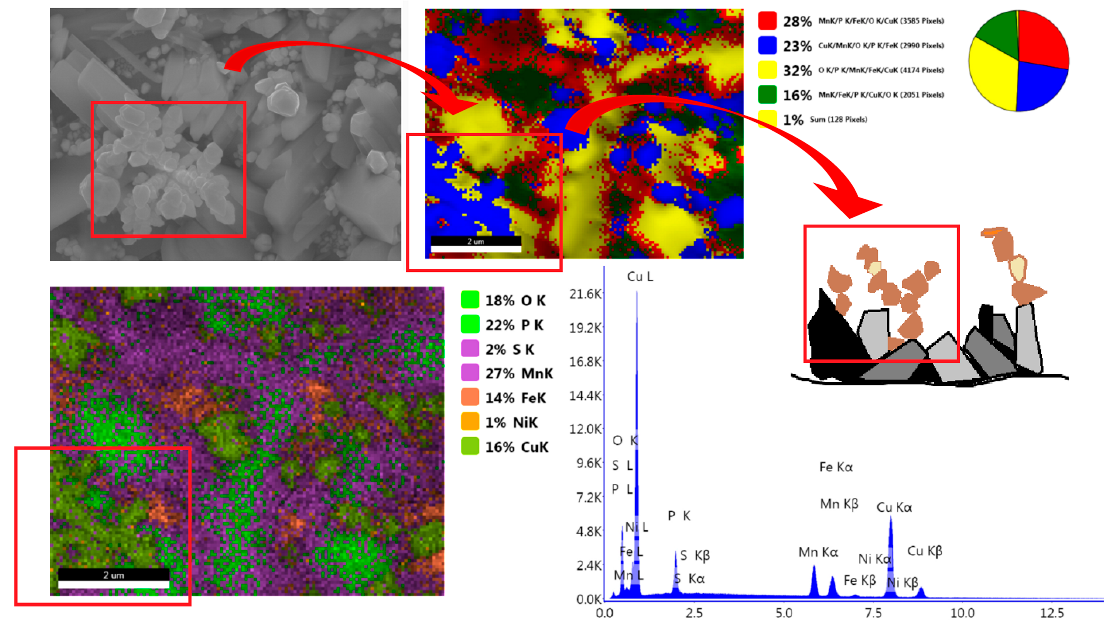
Figure 13. Phosphate coating modified with copper.